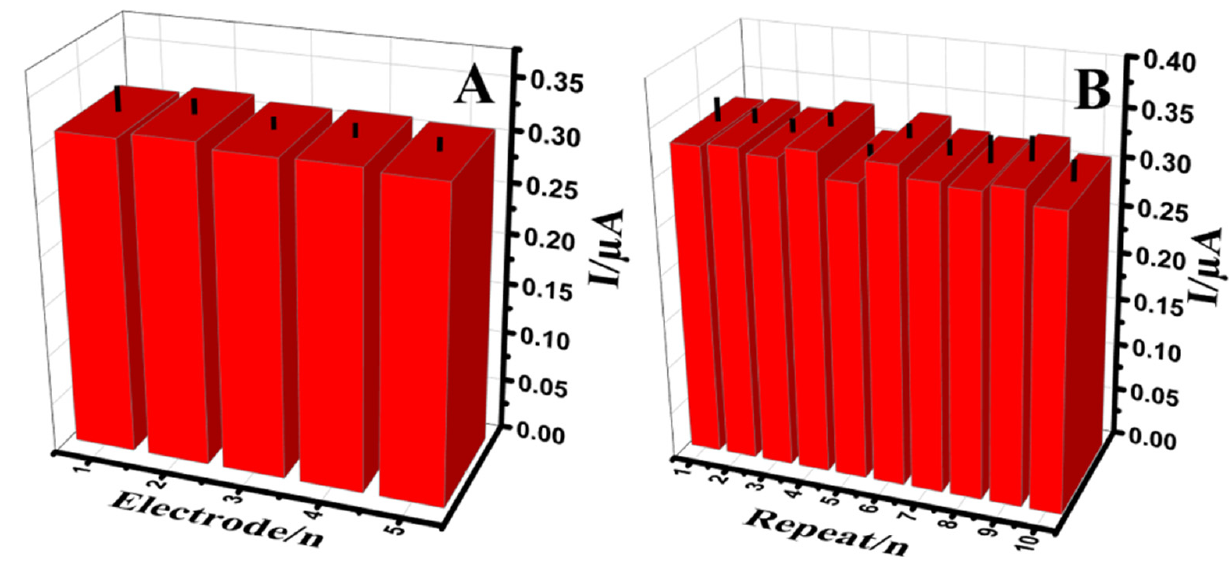
Figure 8. The histogram ( A ); Reproducibility ( B ); repeatability measurements of the Au@NiFe 2 O 4 /SPE in the presence of 0.5 µM EPR containing 0.1 M B-R buffer at pH 4.0.